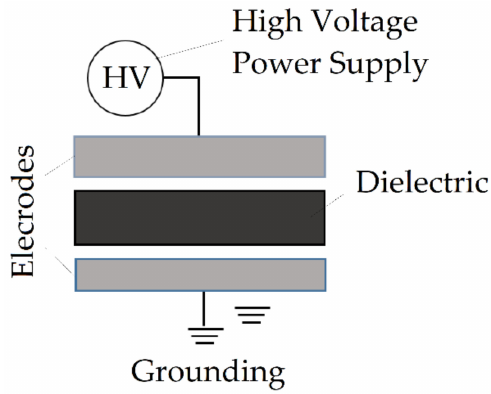
Figure 6. Corona devices used for surface